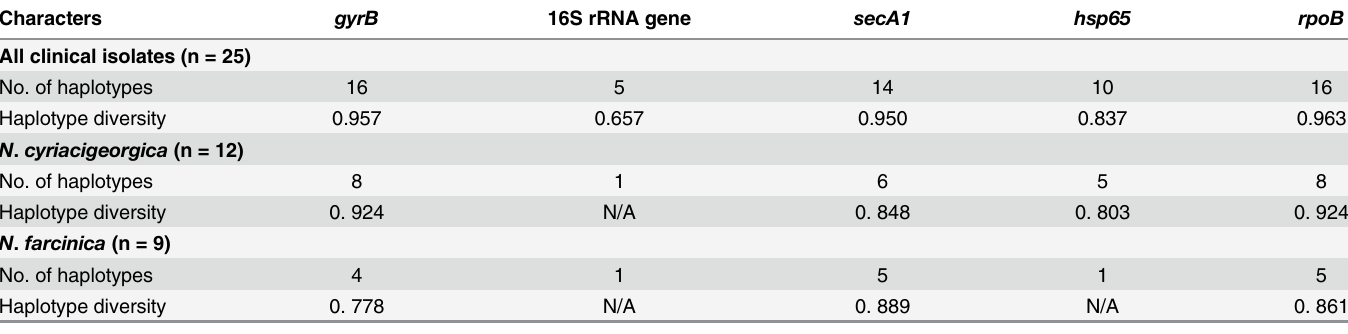
Table 3. Genetic polymorphisms contained within the 16S rRNA, gyrB , secA1 , hsp65 and rpoB genes for 25 clinical Nocardia isolates studied.